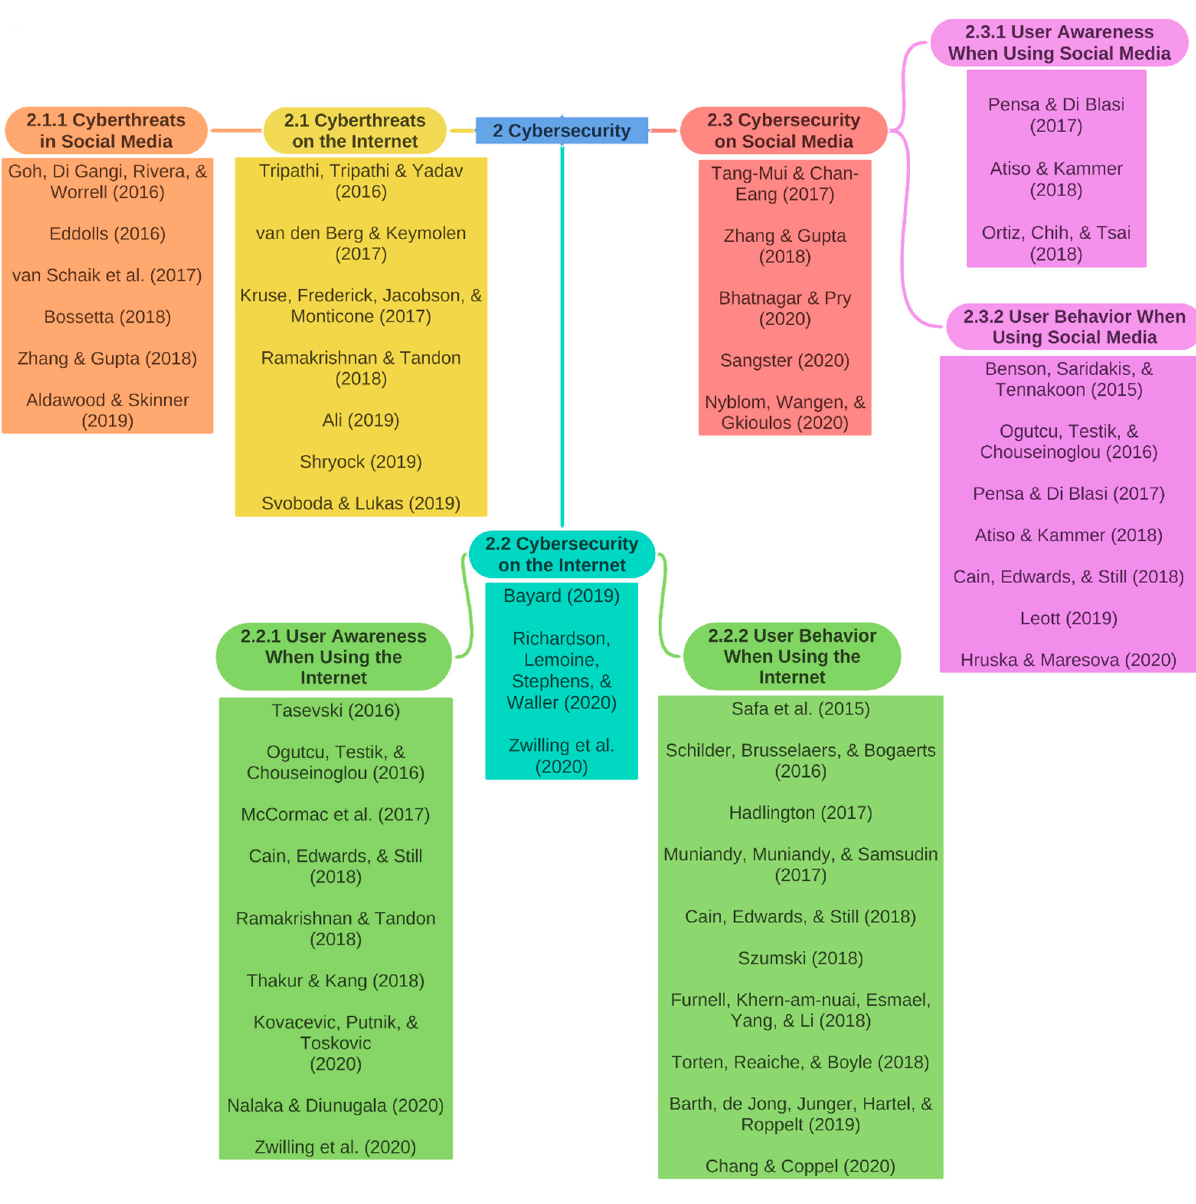
Figure 2. Concept map of the literature related to cyber threats and cybersecurity.